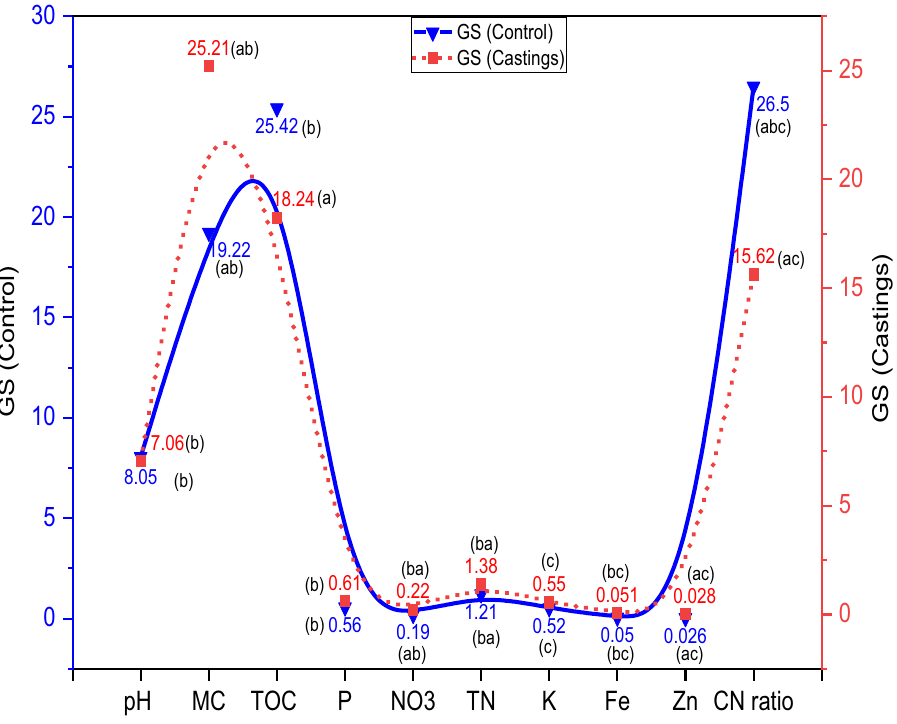
Figure 6. Physico-chemical characteristics of garden soil (initial) and coprolites of garden soil (GS) with and without A. caliginosa (mean ± SD). Corresponding means followed with same letters are not significantly different at P <